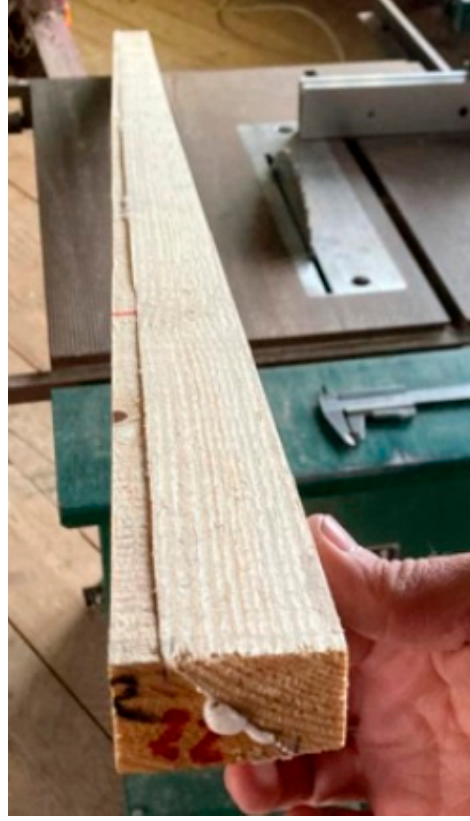
Figure 4. Reconstituted board after edge-cutting at 45°, anti-parallel rotation at 180°, and gluing of two tapered mirrored sideboards.